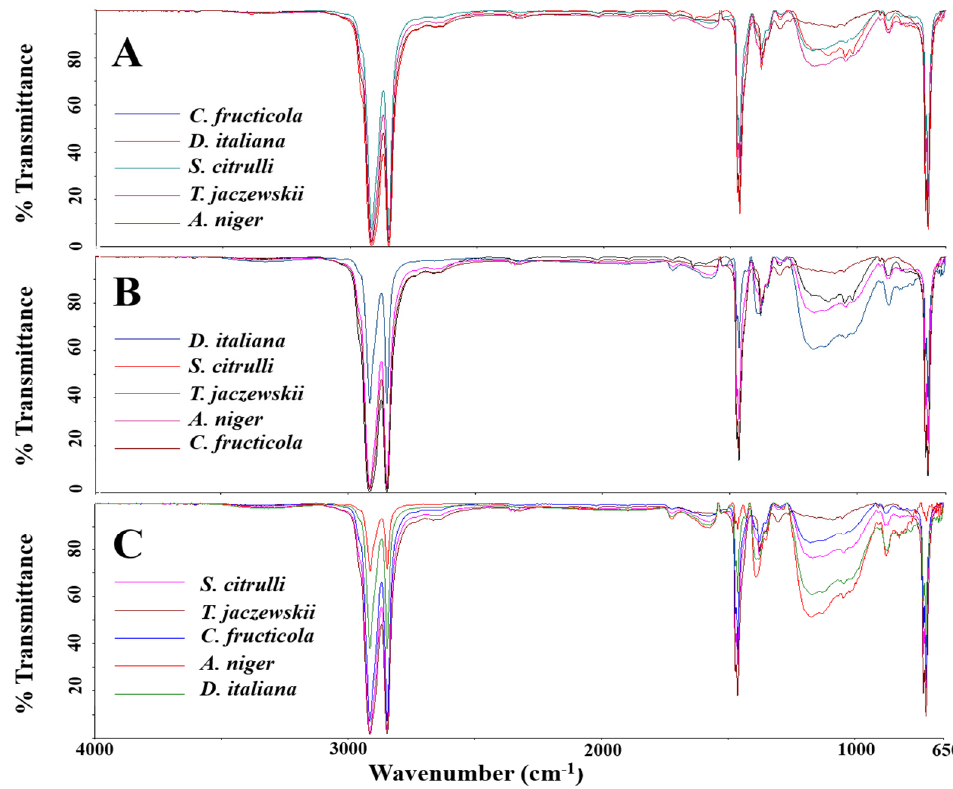
Figure 6. Spectra from FTIR analysis of LDPE films cultured with D. italiana , T. jaczewskii , C. fructicola , S. citrulli , and A. niger after 30 ( A ), 60 ( B ), and 90 ( C ) days of incubation.